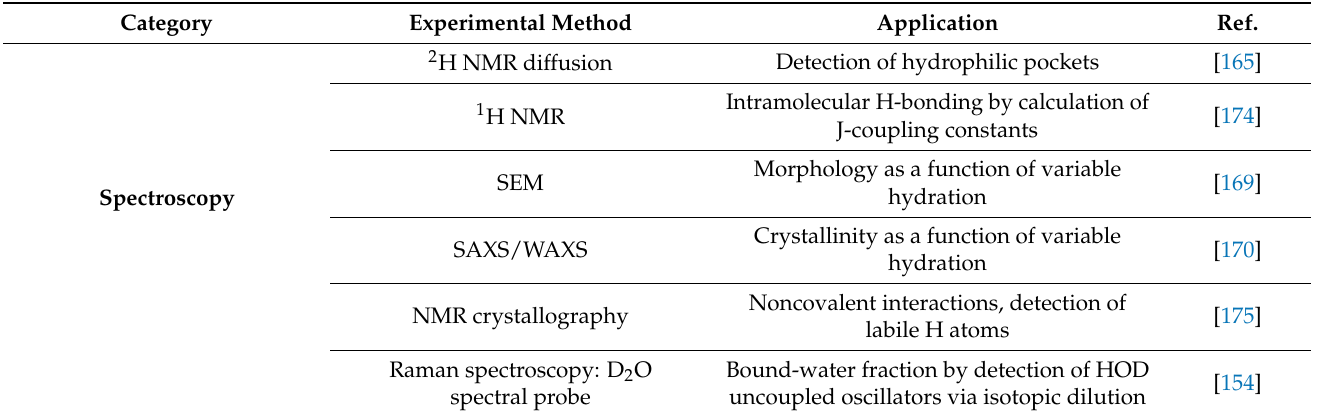
Figure 21. B3LYP/3-21G** calculated structural model for a hydrated PANI-Si-ZnO composite: ( a ) first, ( b ) second, and ( c ) third hydration shells of the PANI-Si-ZnO composites with 5, 10, and 20 molecules, respectively. Based on DFT results from [173]. Table 7. Selected experimental studies for the study of hydration processes.